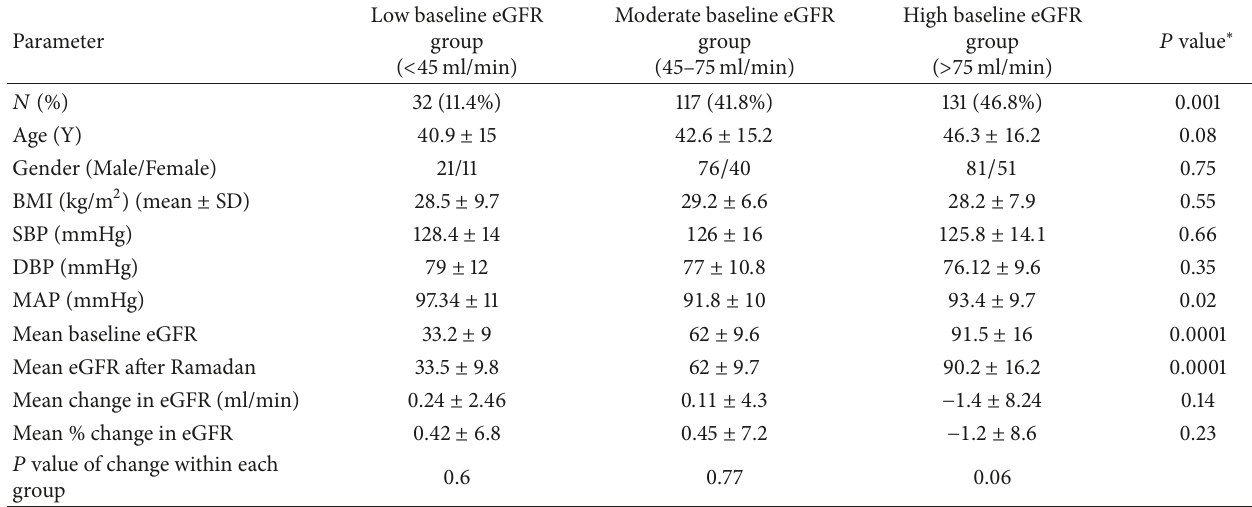
Table 5: Comparing changes in renal function among fasters with different baseline GFR a , b